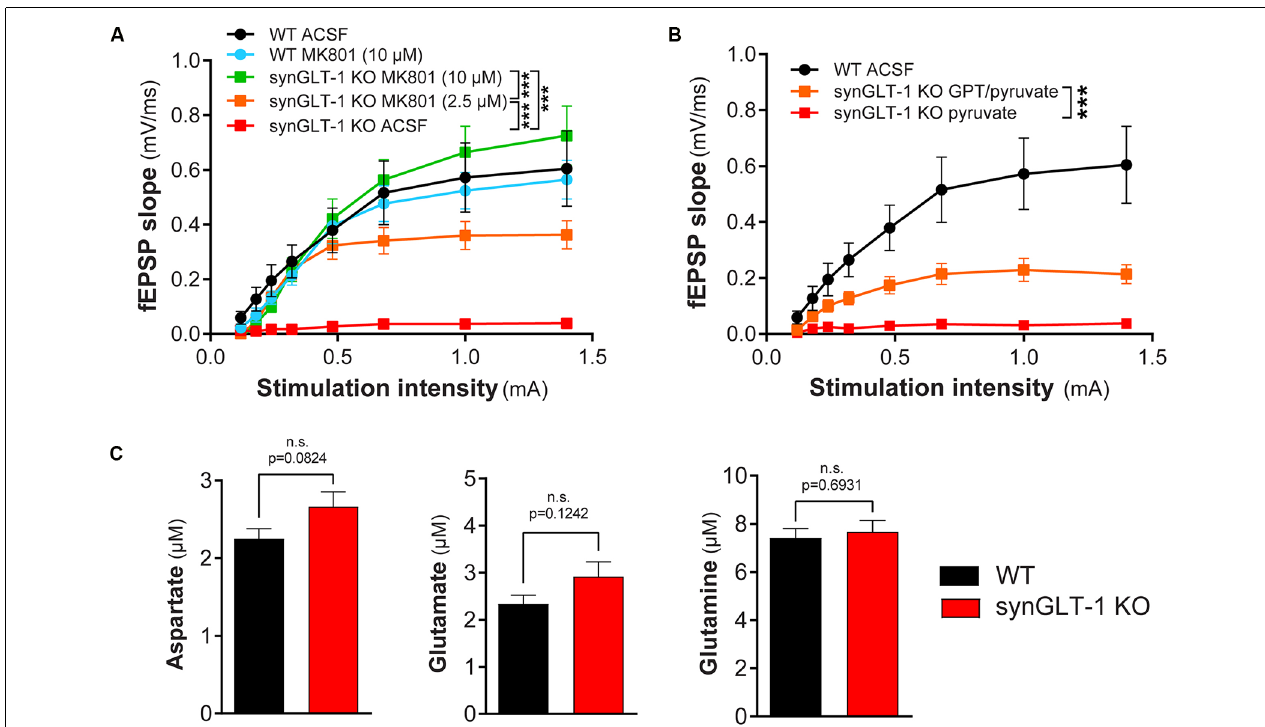
FIGURE 6 | Functional impairment of hippocampal slices was blocked by MK801 or by glutamate-pyruvate transaminase (GPT) in recovery ACSF. (A) The non-competitive NMDA receptor blocker MK801 prevented synaptic transmission compromise in synGLT-1 KO slices. Brain slices were allowed to recover in ACSF or ACSF containing MK801 (10 µ M or 2.5 µ M). Incubation with either 2.5 and 10 µ M MK801 significantly increased the fEPSP slope in synGLT1-KO slices. SynGLT-1 KO slices in the presence of 10 µ M MK801 (green, 11 slices from four mice) showed a normal input-output relationship compared with WT-ACSF slices (black, nine slices from five mice). A low dose of MK801 (2.5 µ M, orange, nine slices from three mice) partially restored fEPSP generation. In ACSF without drug, synGLT-1 KO (red, seven slices from three mice) showed very abnormal I/O. Slices from littermate controls exposed to 10 µ M MK801 during the recovery period (WT-MK801, blue, eight slices from two mice) showed responses similar to slices from littermate controls that recovered in ACSF alone (WT-ACSF, black). *** = p < 0.001 indicates the effect of drug dose in a linear mixed model. (B) The glutamate scavenger system GPT/pyruvate partially prevented synaptic transmission deficits in synGLT-1 KO slices. SynGLT-1 KO slices in the presence of GPT/pyruvate (GPT 10 unit/ml, 10 mM pyruvate, orange, 12 slices from three mice) showed a partially restored input-output relationship compared with slices treated only with pyruvate (red, nine slices from three mice). *** = p < 0.001 in panel (B) indicates effect of GPT in a linear mixed model. (C) Extracellular amino acids following 60 min incubation. Extracellular medium bathing single slices for the recovery incubation period of 60 min was collected and assayed for amino acids. The medium volume was 3 ml. No reliable differences were noted in extracellular glutamate, aspartate, or glutamine concentrations between synGLT-1 KO and wild-type littermate